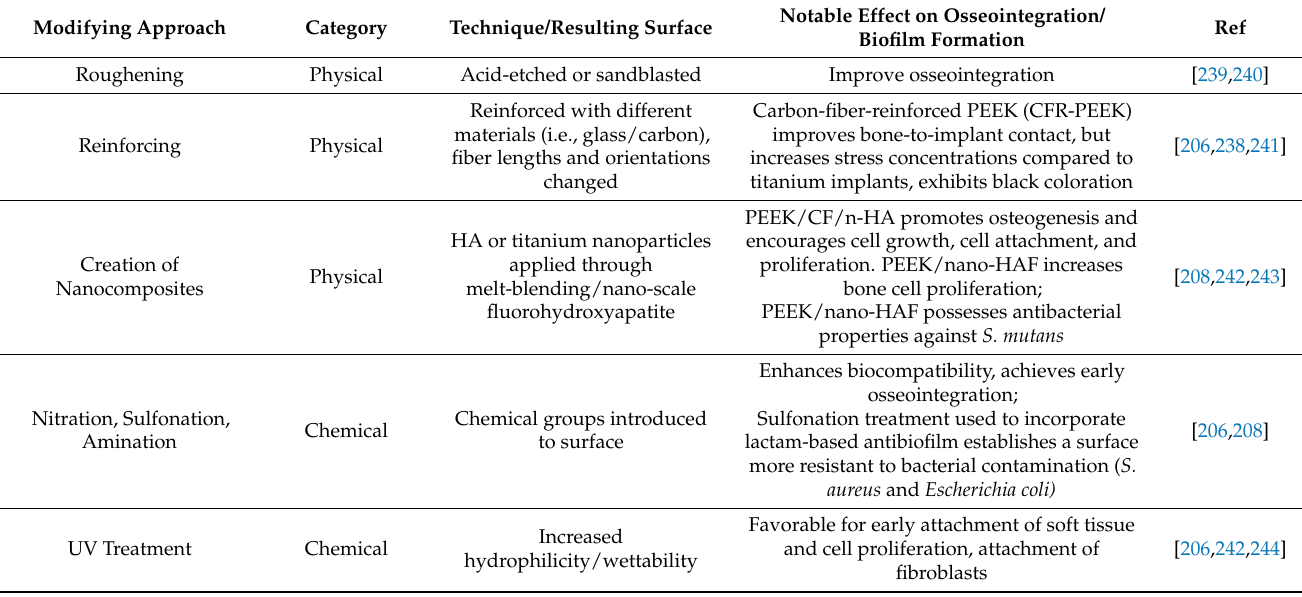
Table 3. The list of PEEK implants’ surface modification